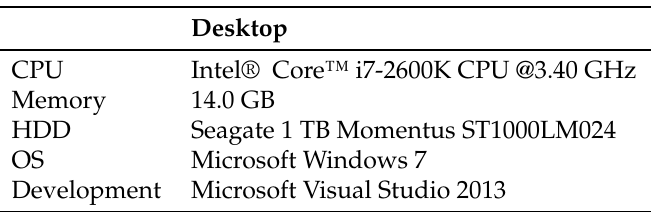
Table 5. Experimental environment.